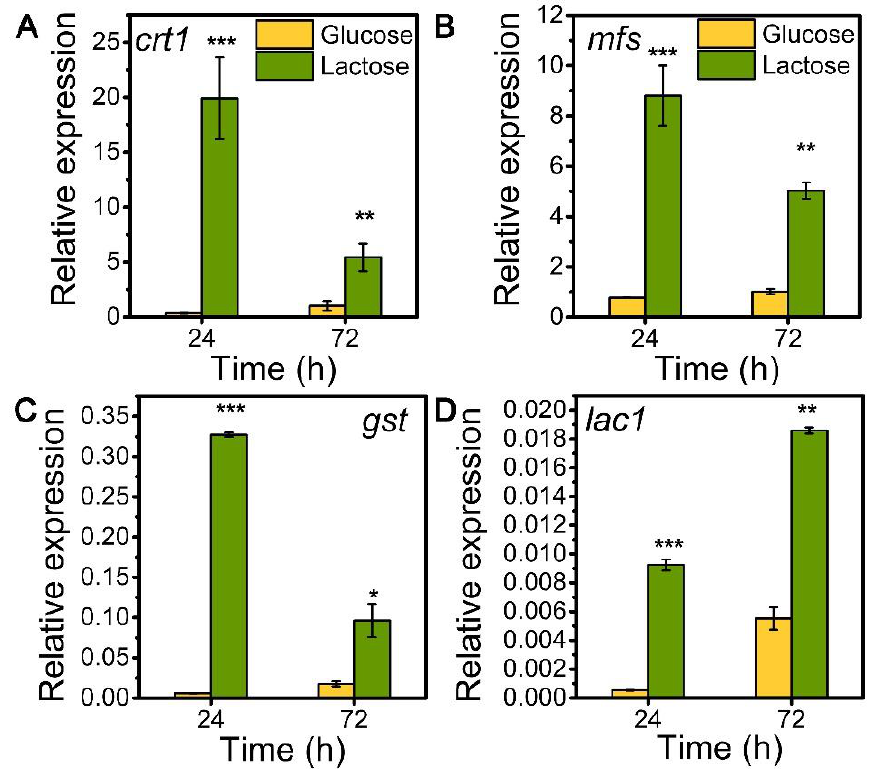
Figure 1. Transcription levels of sugar transporter genes (A) crt1 , (B) mfs, (C) gst , and (D) lac1 in T. reesei Rut-C30 cultured on TMM+2% lactose/glucose at 24 h and 72 h. Values are the means of three biological replicates, and error bars are the standard deviations of these three replicates. The gene expression level was calculated using the 2 −ΔCt method. The relative mRNA level of each tested gene was normalized to the housekeeping gene sar1 . * p < 0.05, ** p < 0.01, and *** p <